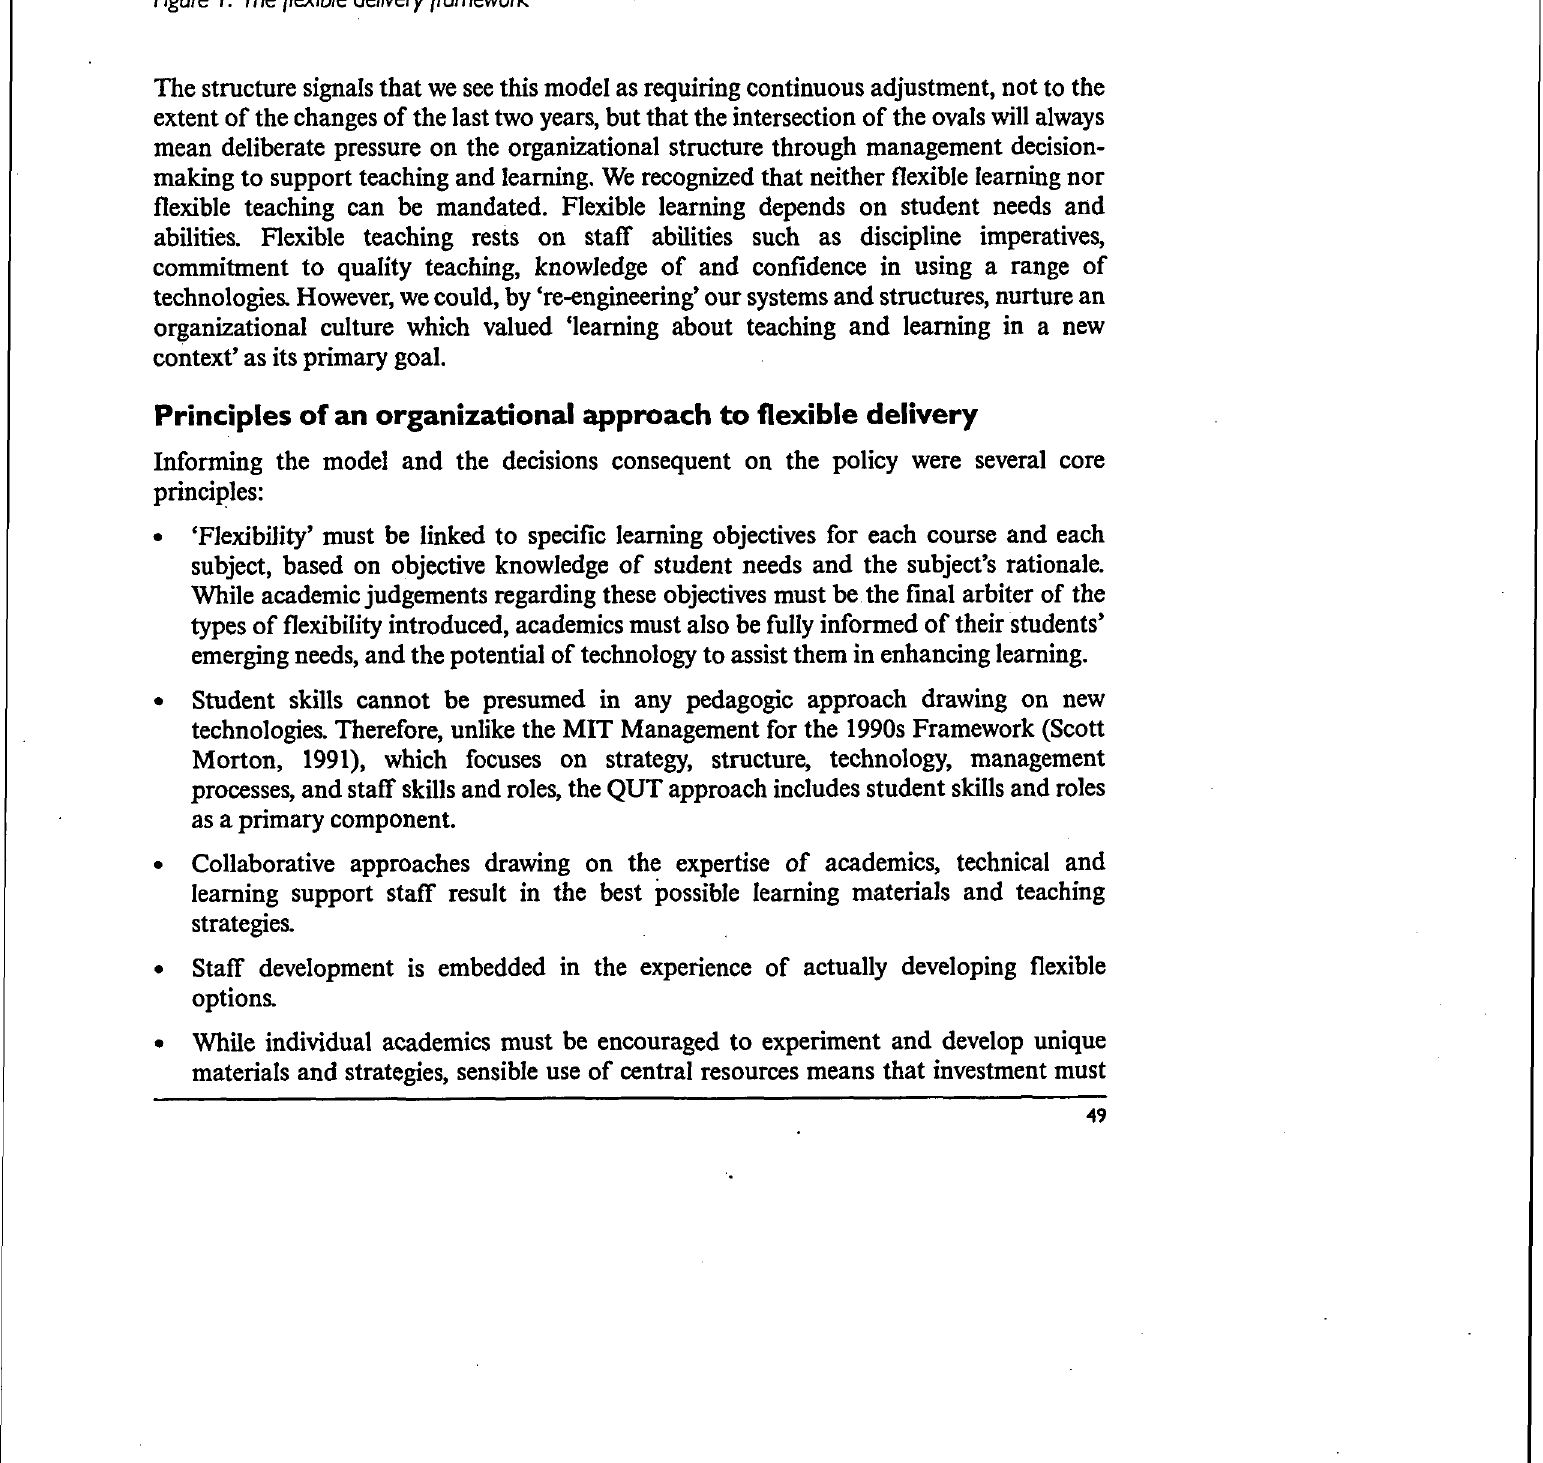
figure /: The flexible delivery